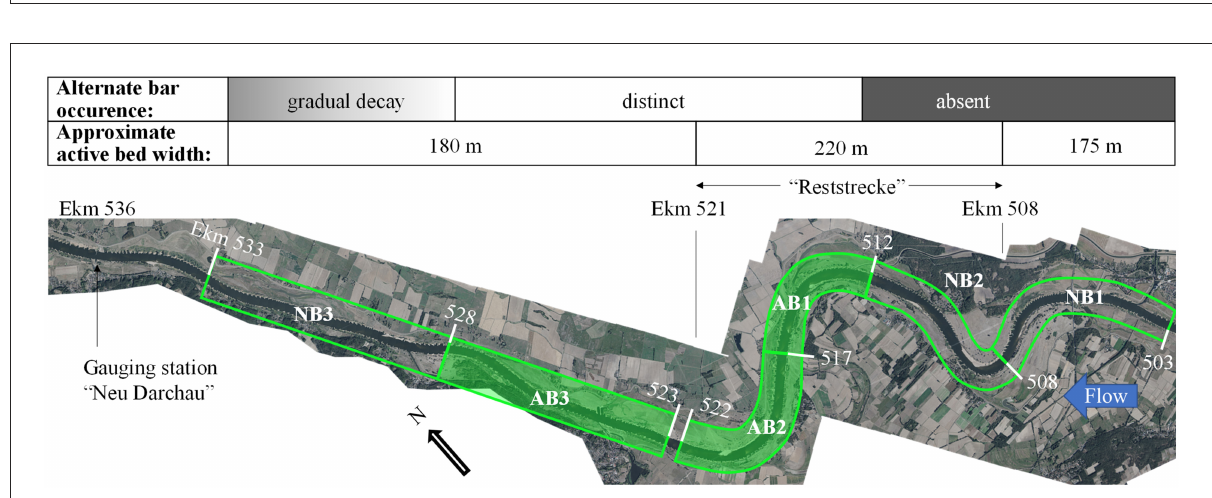
FIGURE2 Overview of the investigated river sections NB1-3 and AB1-3, including the river kilometers, the approximate width of the active riverbed as well as the occurrence of alternate bars. Flow from right to left (Orthophoto courtesy of